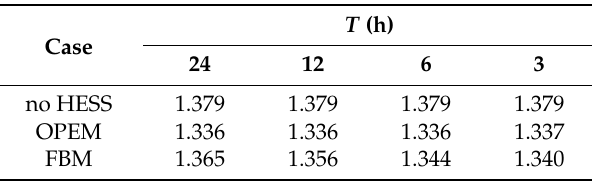
Table 9. Objective function values ( Θ , in MW RMS